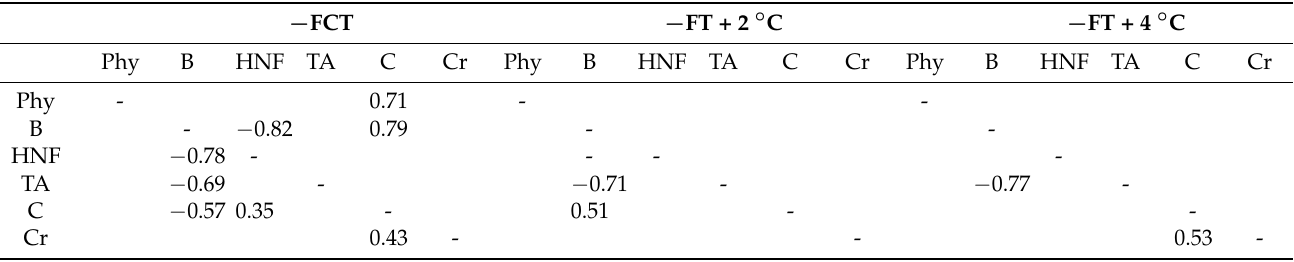
Table 2. Linear correlation coefficients between microbial components and metazoan in the inves ‐